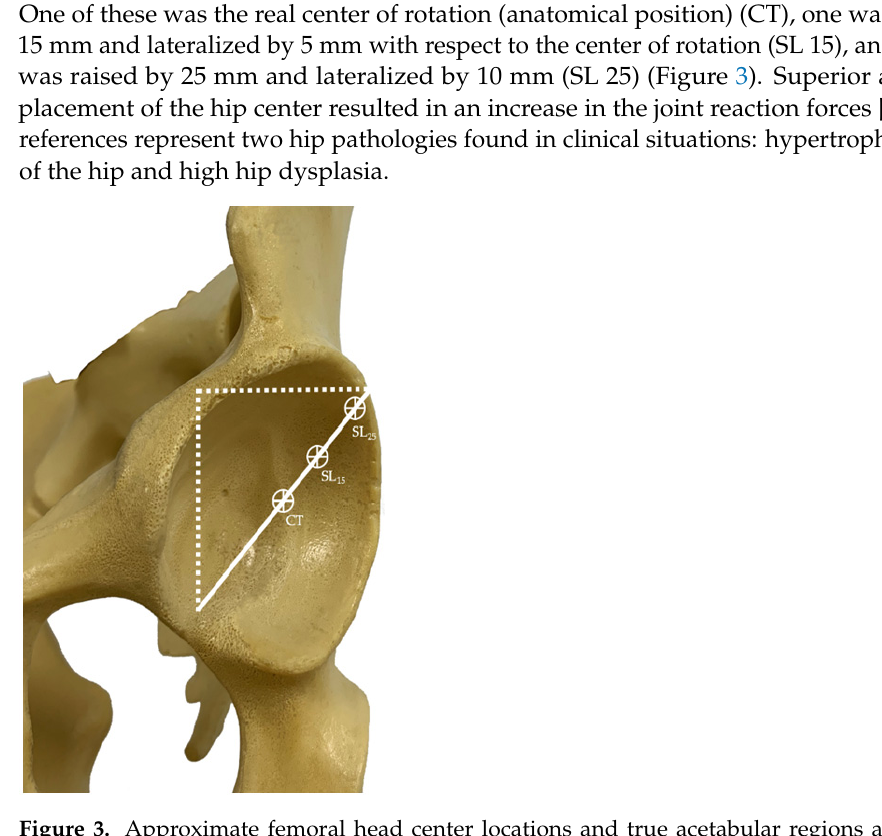
Figure 3. Approximate femoral head center locations and true acetabular regions according to Ranawat. CT (natural anatomical location), SL 15 (superior and lateral location with 15 mm of displacement from CT), SL 25 (superior and lateral location with 25 mm of displacement from CT).